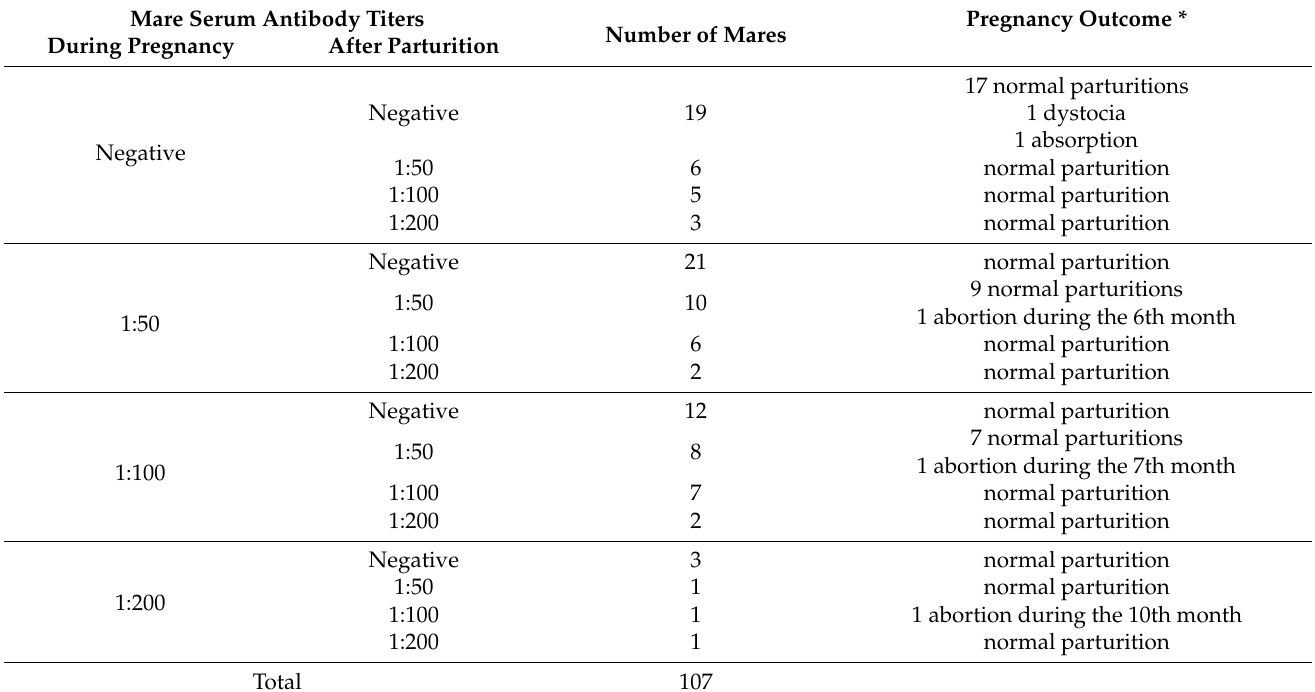
Table 3. Anti- Neospora antibody titer variation detected by IFAT between mare’s pregnancy period and after